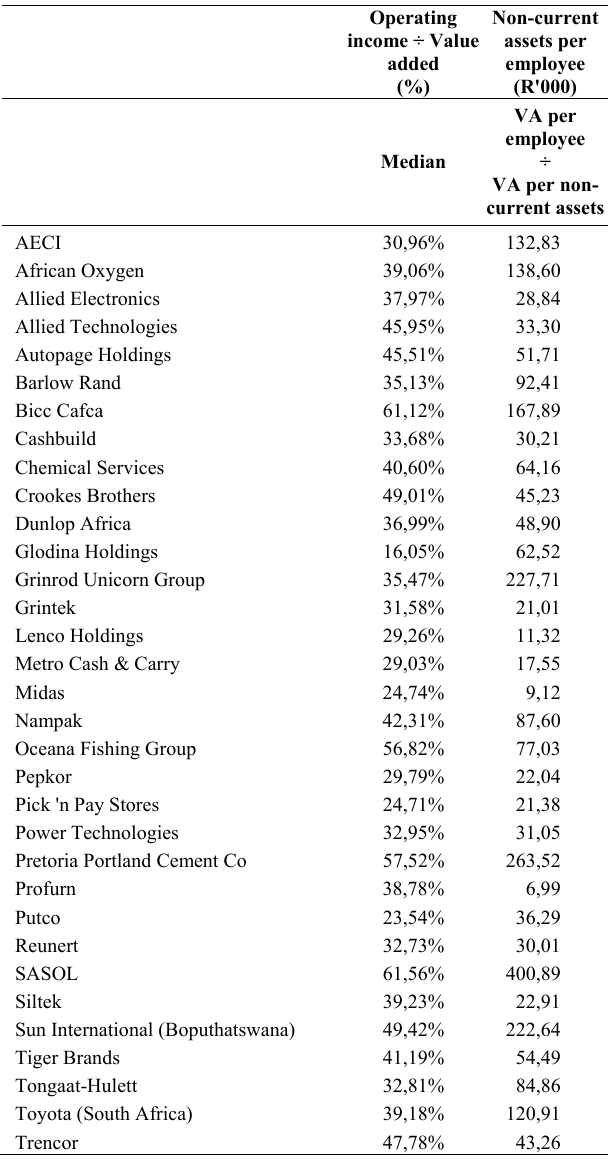
Table 5: Capital reinvestment